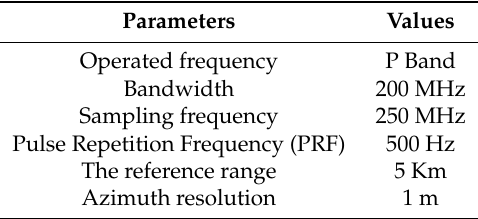
Table 4. Simulation